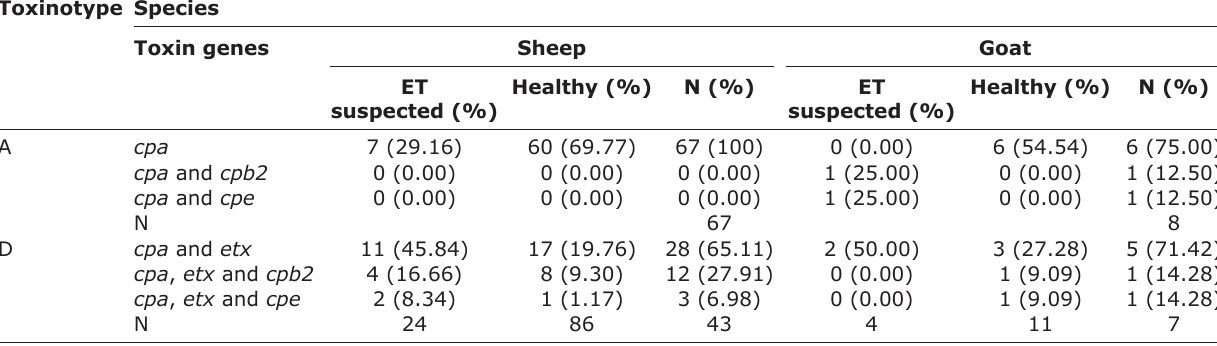
Table-4: Distribution of major and minor toxin genes in Clostridium perfringens toxinotypes isolated from healthy and enterotoxemia suspected sheep and goats. Toxinotype Species